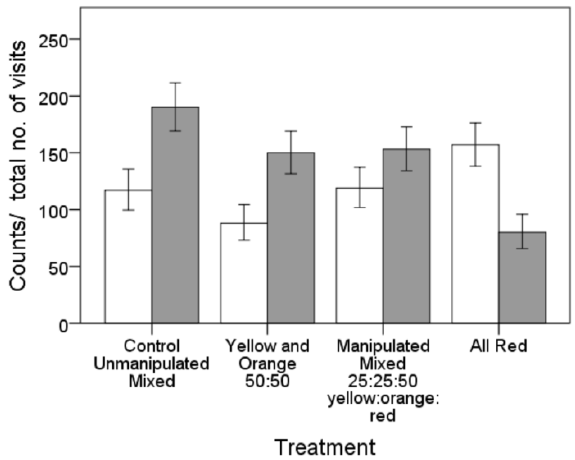
F IGURE 6. Total number (95% CI) of single (white bars) /multiple (grey bars) visits to inflorescences by study species. Highest number of multiple visits by butterflies occurred at Control inflorescence whereas, highest number of single visits occurred at All Red